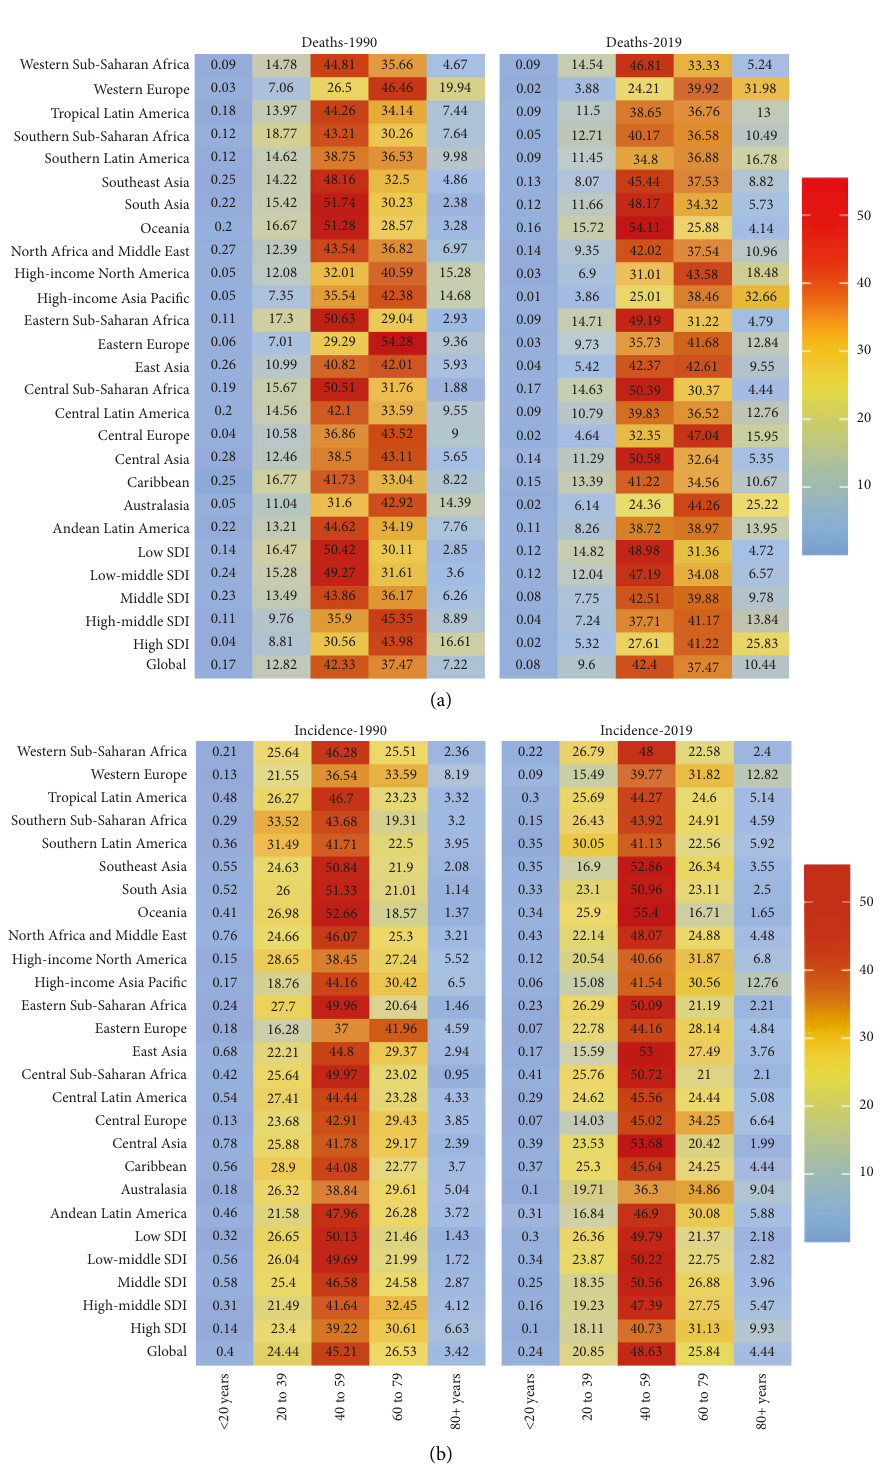
(Additional file1: Figure S4 and S5). Among them, there was a peculiar unimodal distribution (trend of death difference) among all age groups. The peak of low SDI was 60 to 64 years